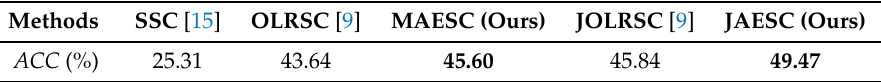
Table 2. Performances of the other methods on the TUT Acoustic Scenes 2017 dataset.